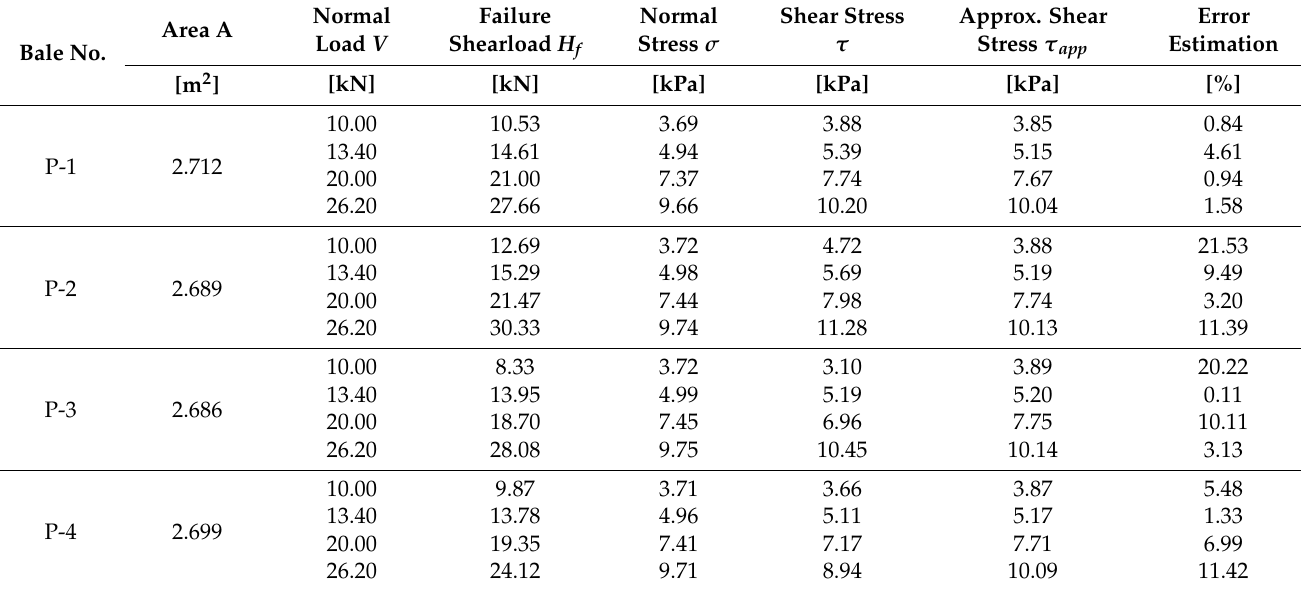
Figure 18. Typical shear stress–displacement curves in subsequent load stages for P-4 specimen. Table 5. Shear and normal stresses along the tyre bale